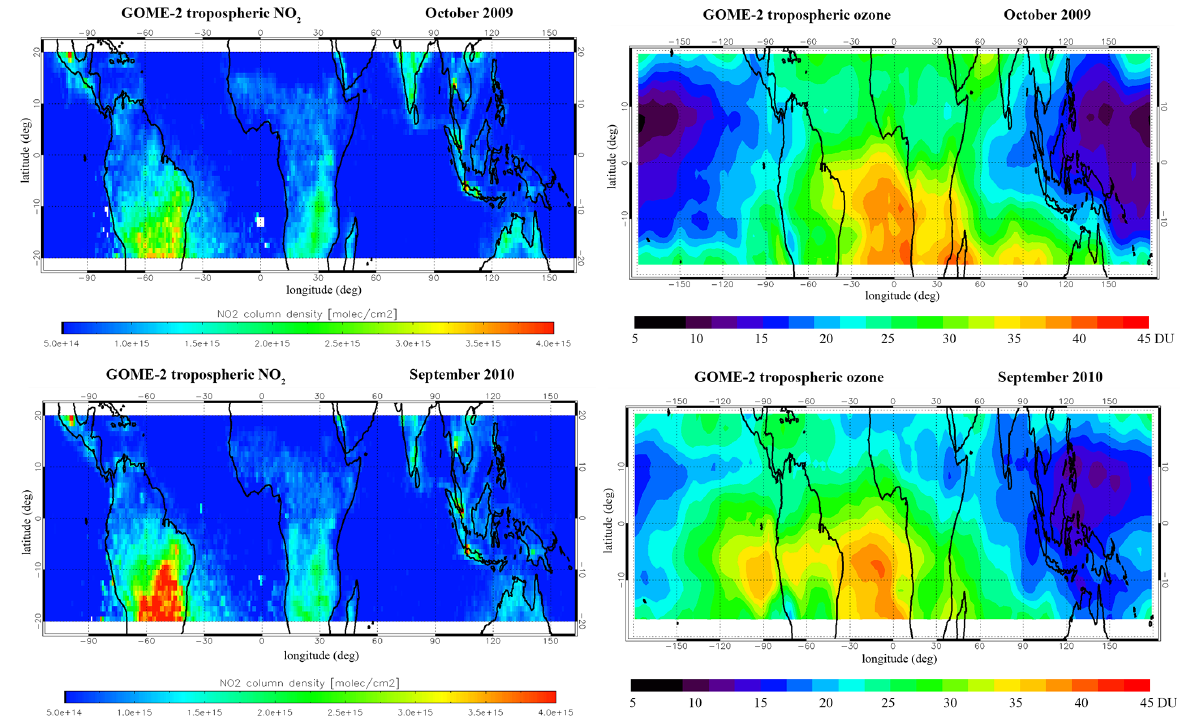
Figure 6. Tropospheric NO 2 (left) and ozone columns (right) as measured by GOME-2/MetOp-A in October 2009 (top) and September 2010